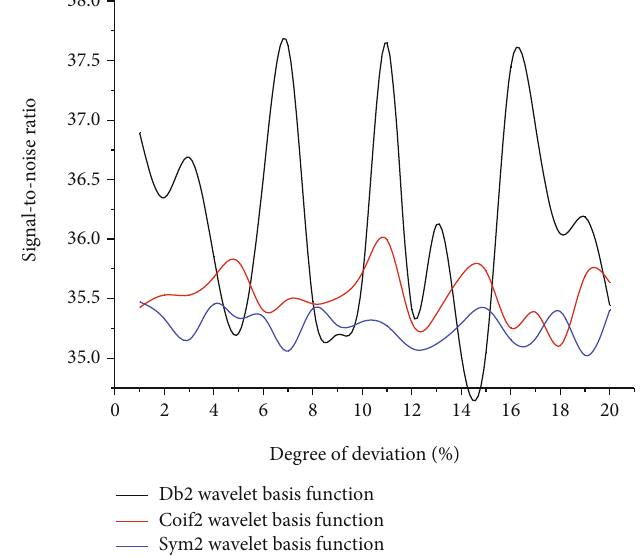
Figure 5: Signal-to-noise ratio after